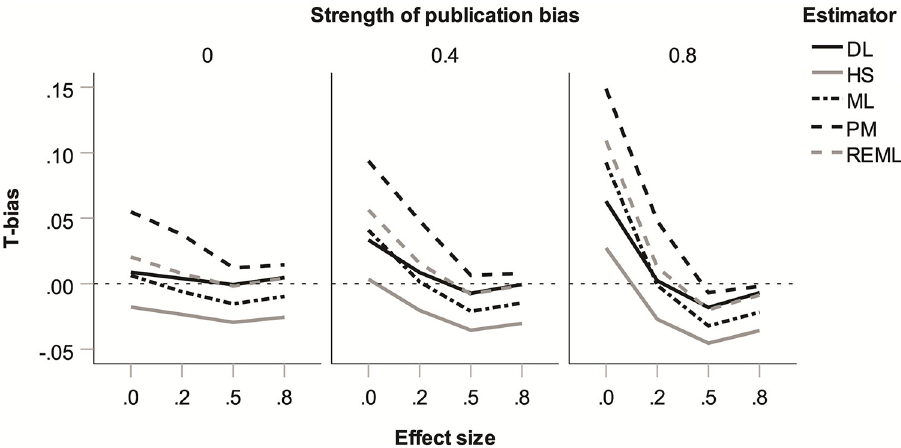
Fig 6. Bias in heterogeneity estimates ( T bias ) for five heterogeneity estimators: Two-way interaction of true average effect size ( θ ) with strength of publication